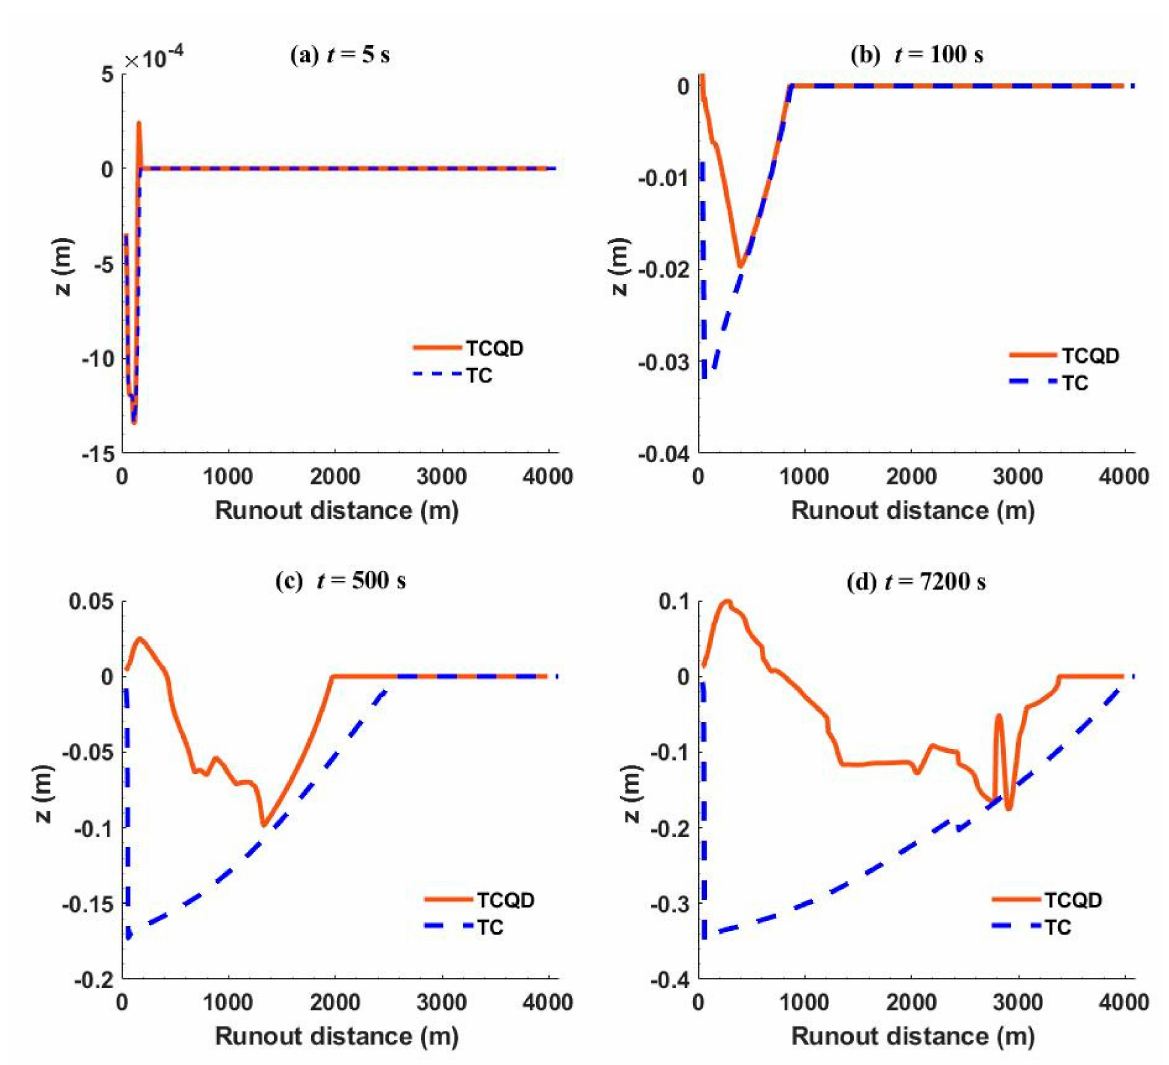
Figure 9. Bed deformation profiles of TCQD and TC at different times. ( a – d ) show the bed deformation profiles at 5 s, 100 s, 500 s, and 7200 s,